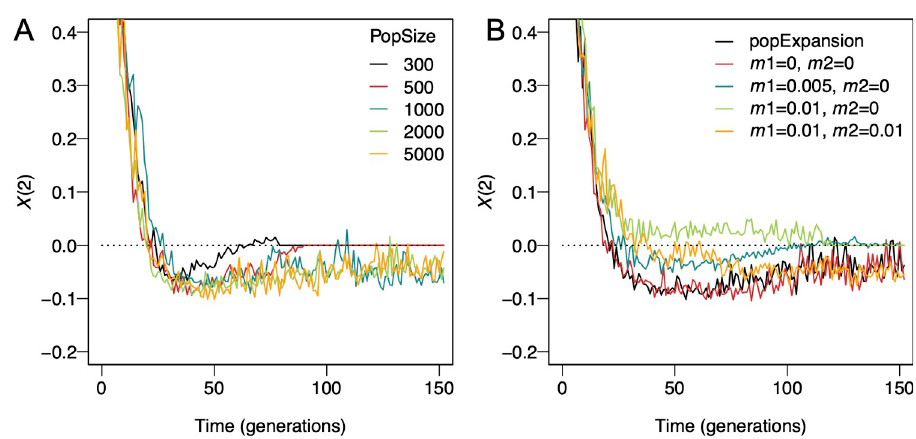
Fig 4. Effect of demographic parameters on the dynamics of X (2) for a DMI in a hybrid population. Each line is one randomly chosen simulation run using SliM, assuming equal admixture proportions of the parental populations and a strong DMI ( α = 0.001, β = 0.002, γ = − 0.5) under a Wright-Fisher model. The recombination probability between the interacting loci was 0.1. 300 individuals were sampled in each simulation independent of the population size. Individuals that did not contain at least 10% of their genome from either parental population were excluded. Trajectories were plotted from generation 2 onwards. A. X (2) dynamics with variable population size. X (2) indicates DMIs when the population size is as small as 300. DMIs are purged more quickly from small populations due to genetic drift. B. X (2) dynamics with population expansion and migration. Immigration rates are m 1 amd m 2 from the two parental populations. The X (2) signal is only mildly affected by population expansion, low asymmetric migration, and symmetric migration from parental populations. Strong migration from one parental population disrupts DMI detection by X (2) (green